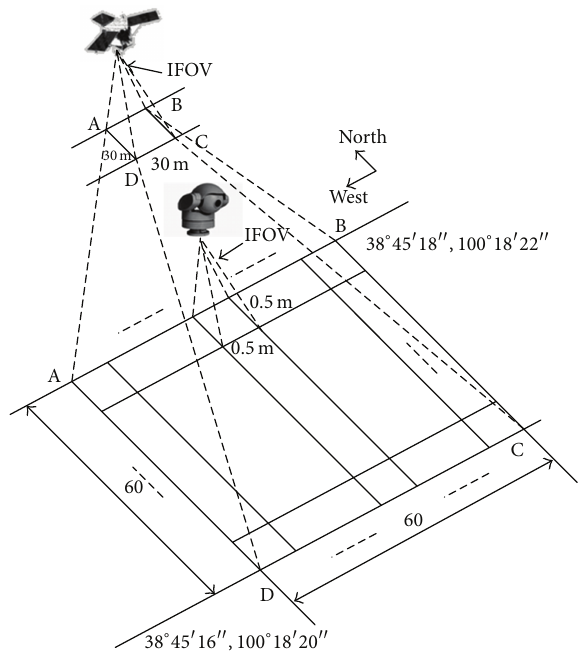
Figure 3: The sketch of the spaceborne and ground based simulta- neous observations.